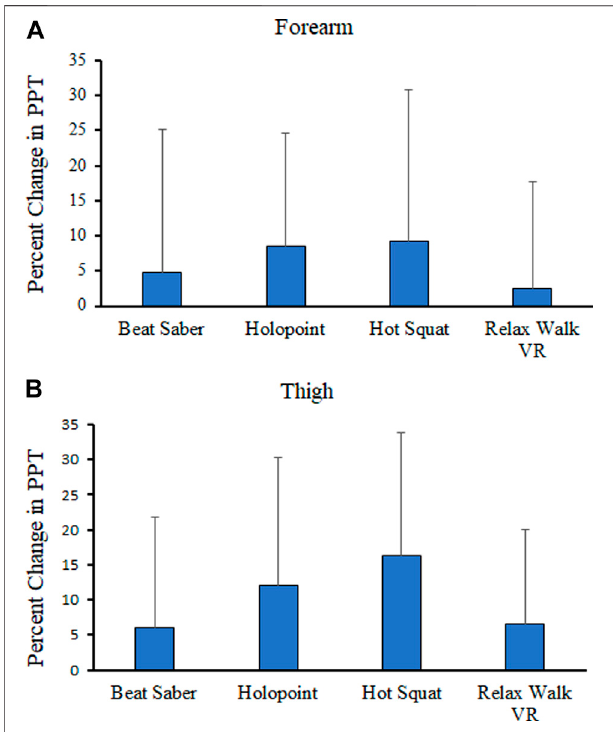
FIGURE2| Meansandstandarddeviations(SD)forPercentageChange (%)inPressurePainThresholdsattheforearm(A)andthigh(B)fromPre-VRto Post-VR across